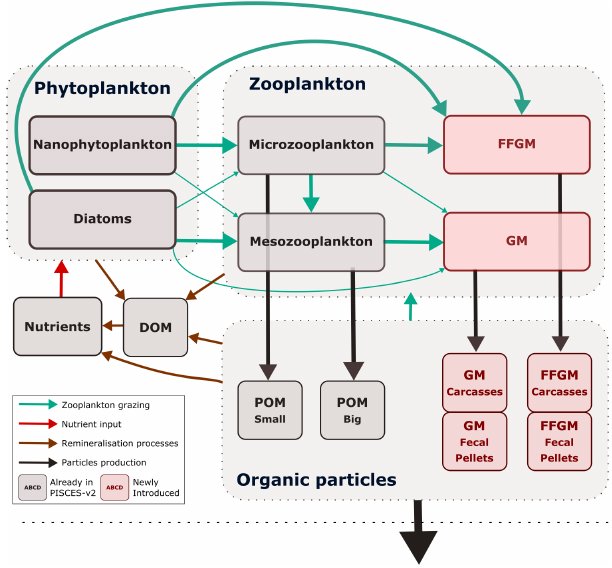
Figure 1. Architecture of PISCES-FFGM. This figure only shows the organic components of the model, thus omitting oxygen and the carbonate system. This diagram emphasizes trophic interac- tions (turquoise arrows, the width representing the preference of the predator for the prey) and particulate organic matter production (black arrows), two processes strongly impacted by the introduction of two new zooplankton groups in PISCES-FFGM (pink boxes). FFGM is for filter-feeding gelatinous macrozooplankton; GM is for generic macrozooplankton; POM is for particulate organic matter; DOM is for dissolved organic